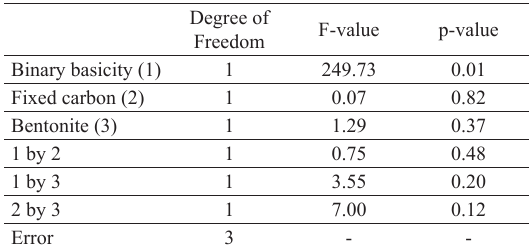
Table 4. Statistical analysis results for the mechanical strength of the fired iron-ore pellets.